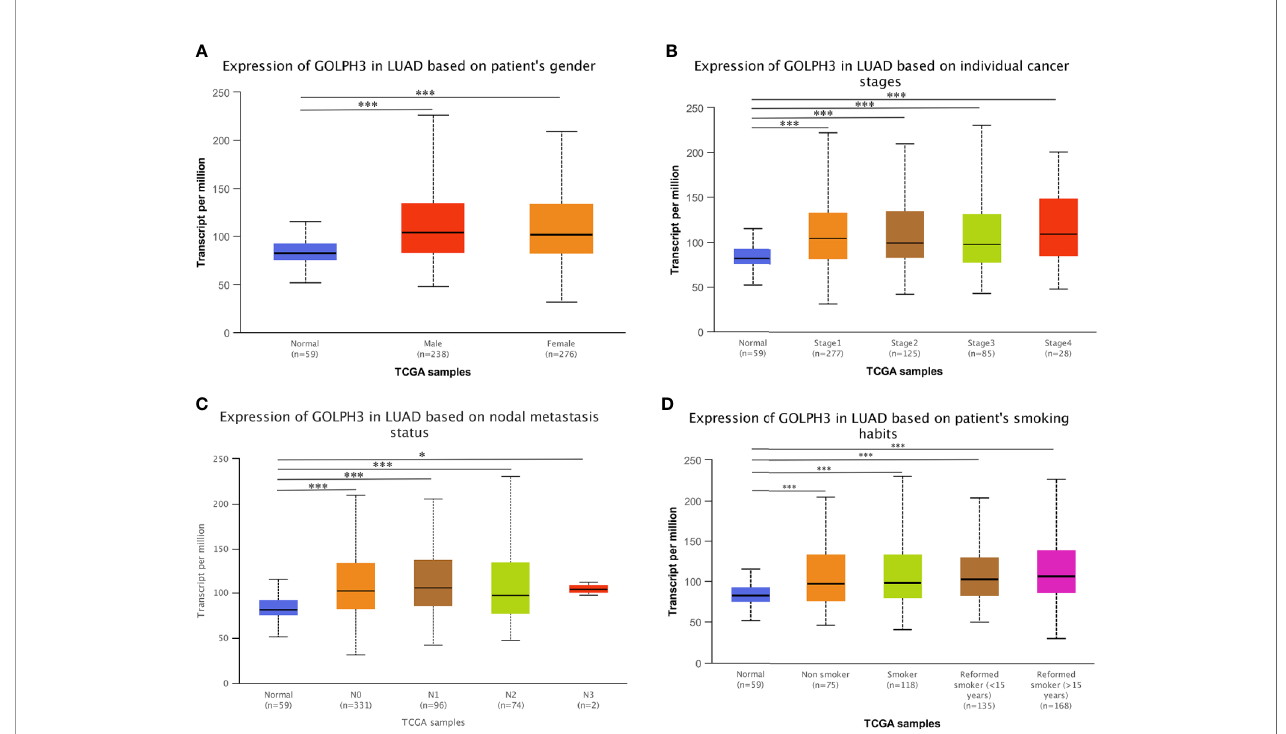
FIGURE 2 | GOLPH3 transcription in subgroups of LUAD patients (UALCAN). (A) The relative expression of GOLPH3 in normal individuals of either gender and in male or female lung adenocarcinoma patients. (B) The relative expression of GOLPH3 in normal individuals or in LUAD patients in stage 1, 2, 3, or 4. (C) The relative expression of GOLPH3 in normal or in LUAD patients in nodal metastasis status N0, N1, N2, or N3. (D) The relative expression of GOLPH3 in normal or in non- smoker, smoker, reformed smoker (<15 years), or reformed smoker (>15 years) LUAD patients. The t-test was used to estimate the signi fi cance of difference in gene expression levels between groups. Data are mean ± SE. * p < 0.05, *** p < 0.001. LUAD, lung adenocarcinoma. All results are available